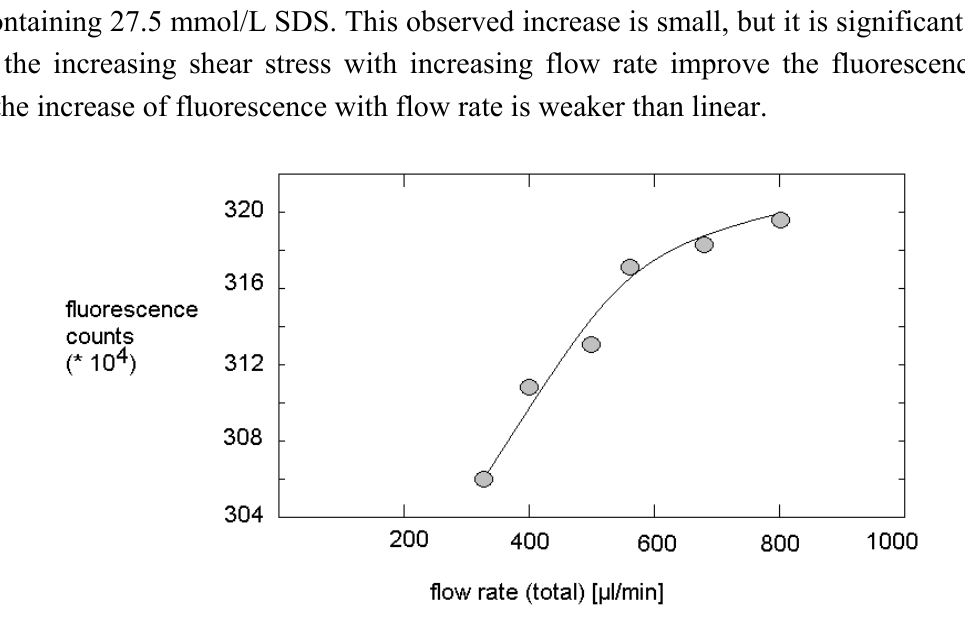
Figure 4. Increase of fluorescence intensity in dependence on flow rate in dye solutions containing 27.5 mmol/L SDS but no quencher (constant dye